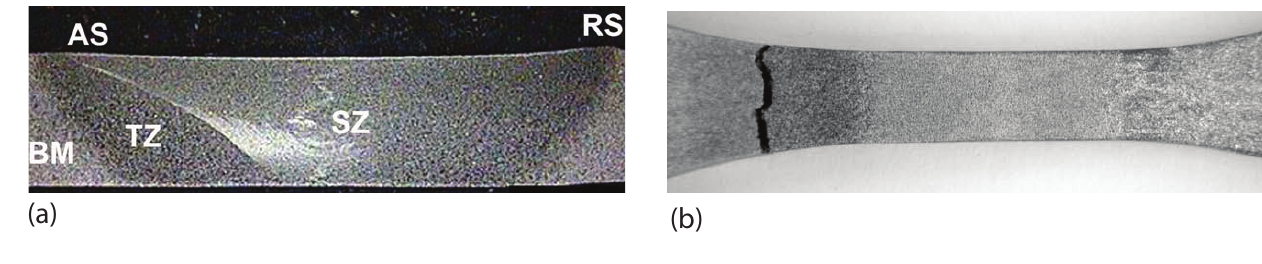
Figure 15 . Macroscopic images of the friction stir processed 22 vol % Al reinforced AA6061 composite showing: (a) the base material (BM), the transition zone (TZ), the stir zone (SZ), the advancing side (AS), and the retreating side (RS); (b) typical location of fatigue fracture in the transition zone (TZ) (after Minak et al.